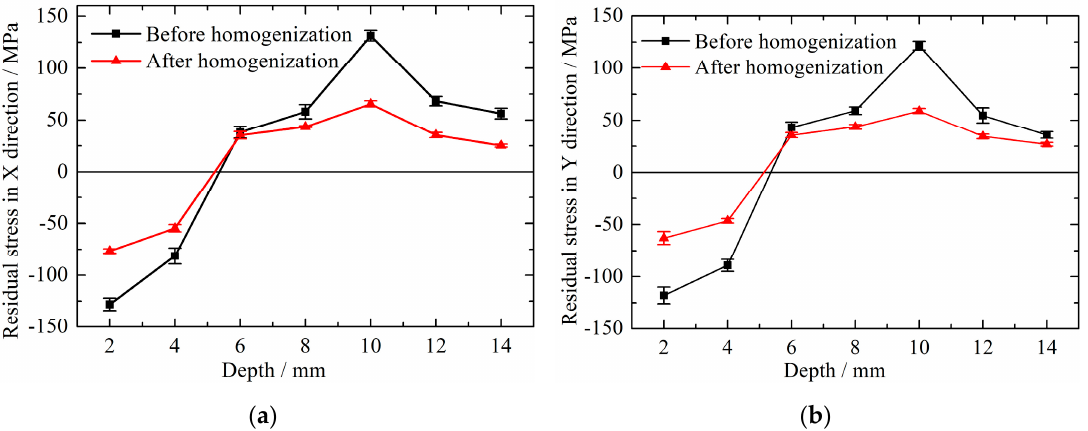
Figure 9. Comparison of residual stress of expansion method. ( a ) Residual stress in X direction; ( b ) residual stress in Y direction.